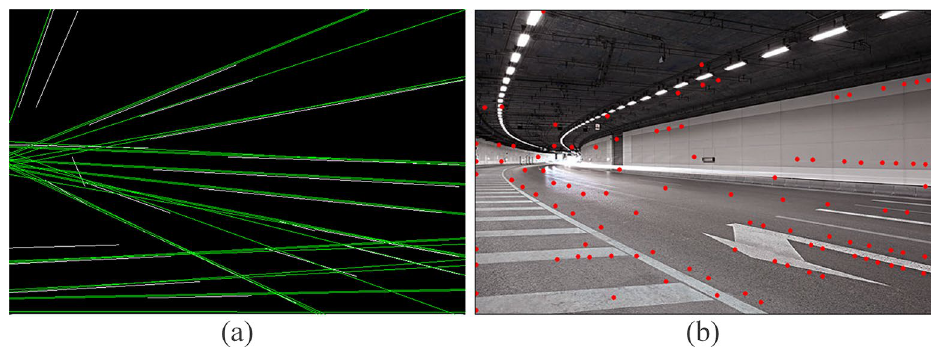
Figure 3. Searching for